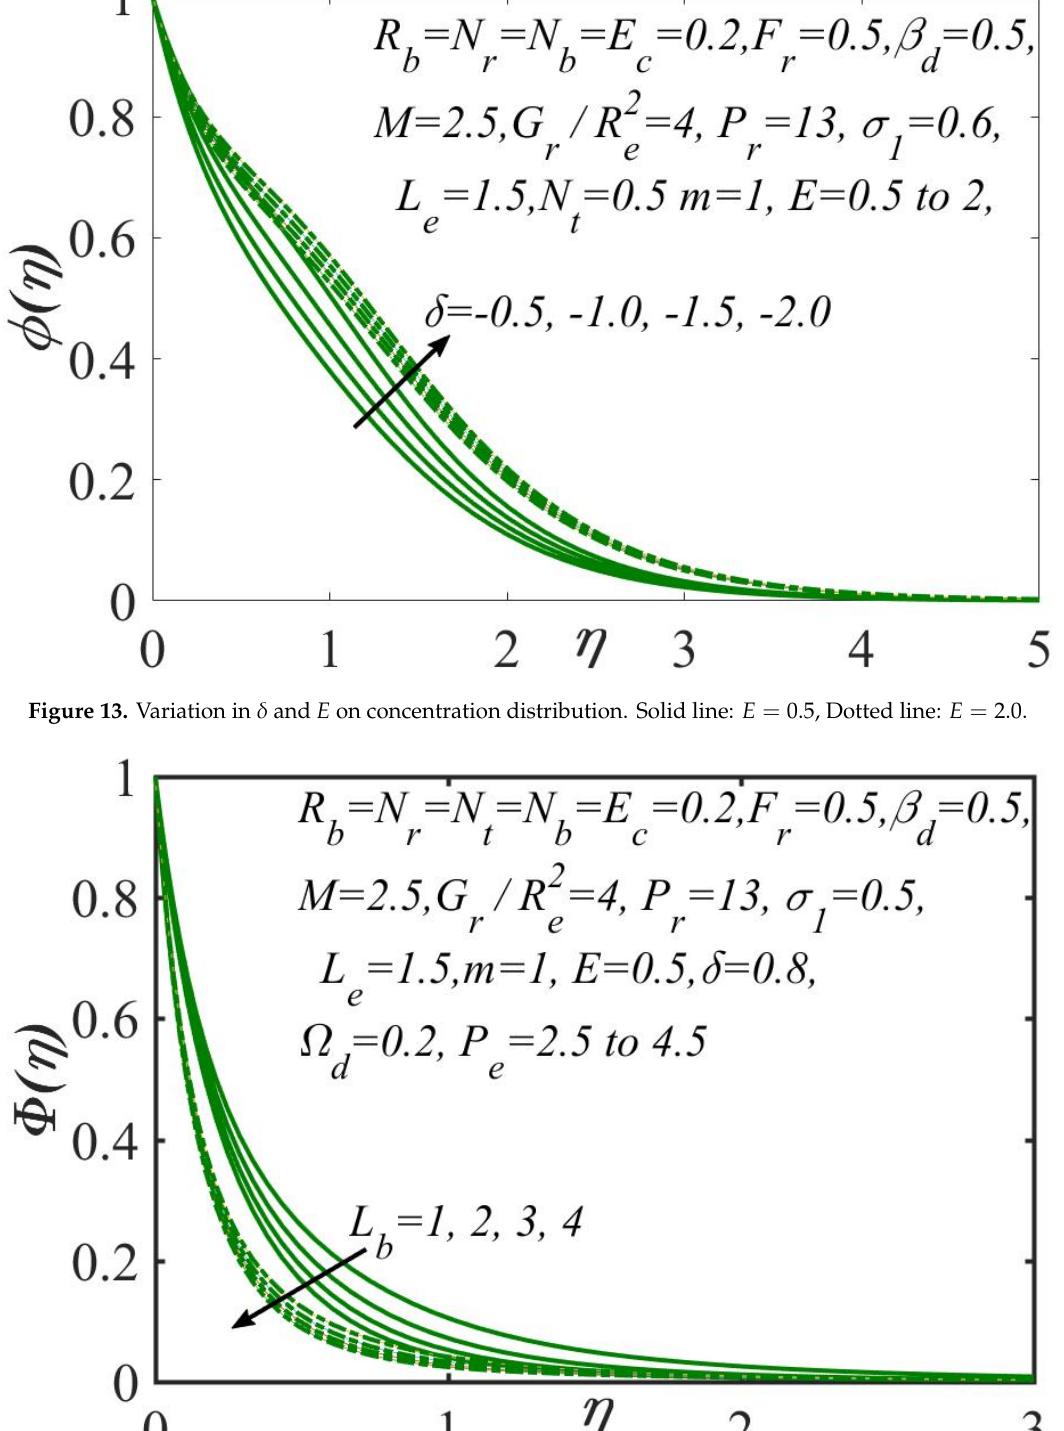
Figure 14. E ff ect of the bio-convection Lewis number L b and Peclet number P e on the density of motile Figure 14. Effect of the bio-convection Lewis number (cid:1838) (cid:3029) and Peclet number (cid:1842) (cid:3032) on the density of microorganisms. Solid line: P e = 2.5, Dotted line: P e = motile microorganisms. Solid line: (cid:1842) (cid:3032) = 2.5 , Dotted line: (cid:1842) (cid:3032) = 4.5.